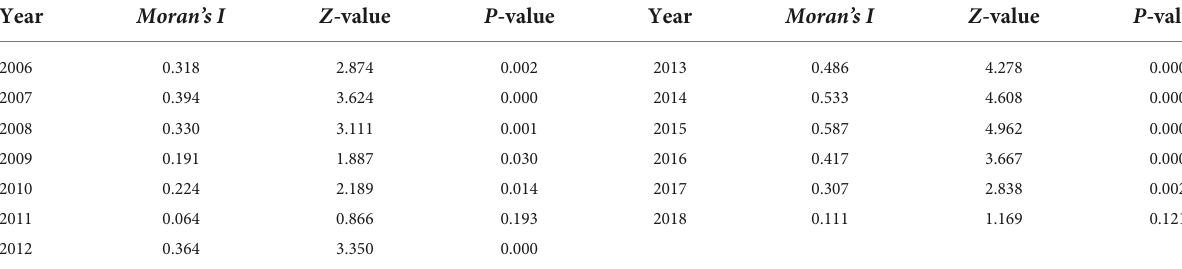
TABLE 9 Univariate Moran’s I index of the industrial green development